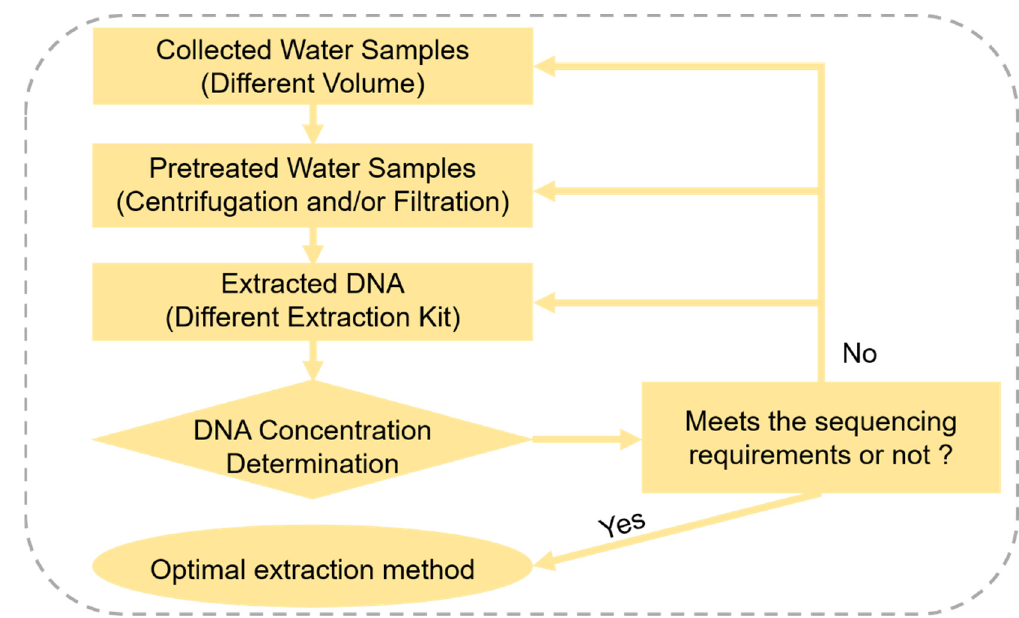
Figure 2. The process of samples pretreatment and DNA extraction.